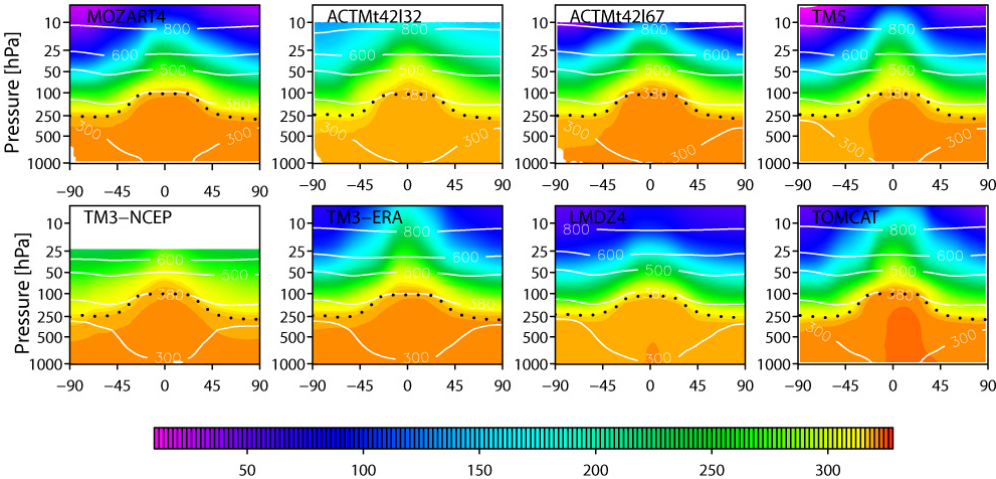
Fig. 2. Simulated zonal and annual mean latitude–altitude cross sections of N 2 O mixing ratio (ppb) from eight models shown for 2007. Superimposed are contours of annual mean potential temperature (K) (white lines) and mean tropopause height (black dotted line).